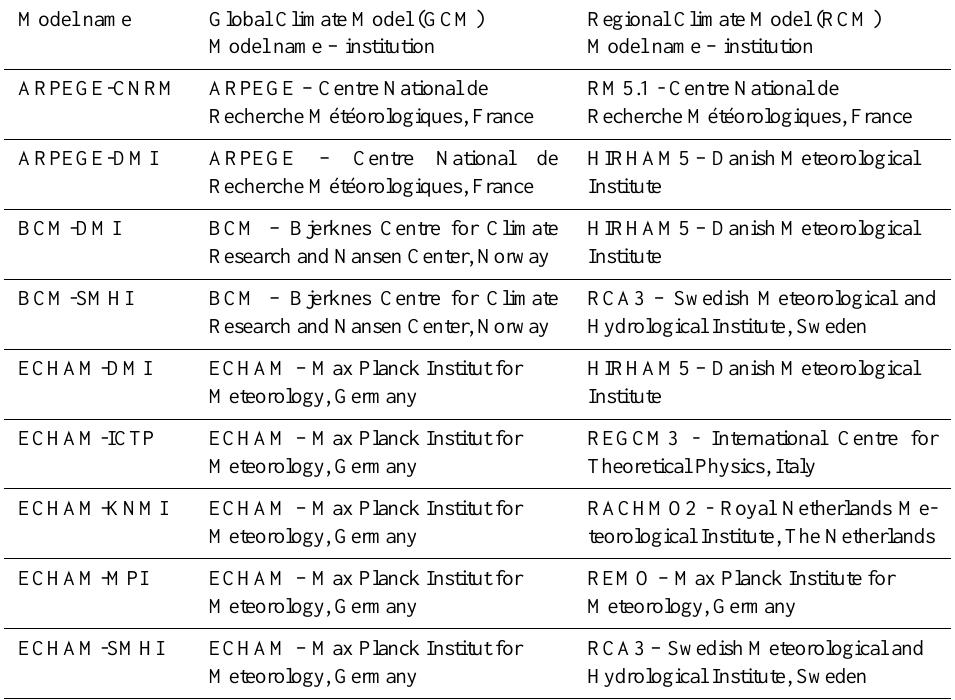
Table 2. Climate model ensemble, combinations of GCMs and